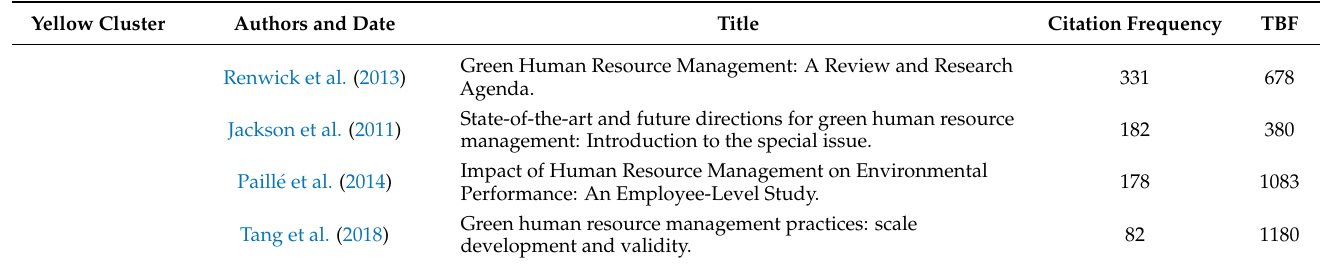
Table A1. Publications from the bibliographic coupling analysis—yellow